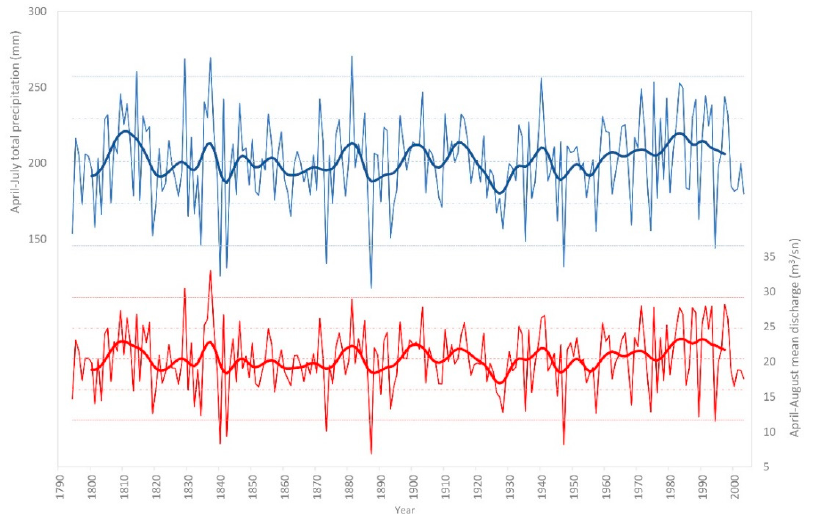
Figure 7. April–July total precipitation (mm) reconstruction of the lower KRB (blue line, upper) and April–August mean Gök ı rmak River streamflow (m 3 /s) reconstruction (red line, lower). The dashed blue (red) central, inner and outer horizontal lines indicate the mean of estimated values and the border of 1(2) SDs from the mean, respectively, and the solid red (blue) line shows the 13-year low-pass filter